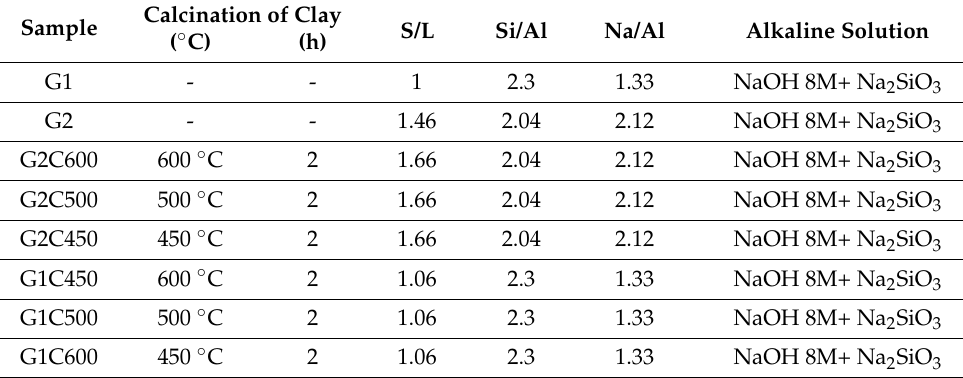
Table 3. Formulations of the